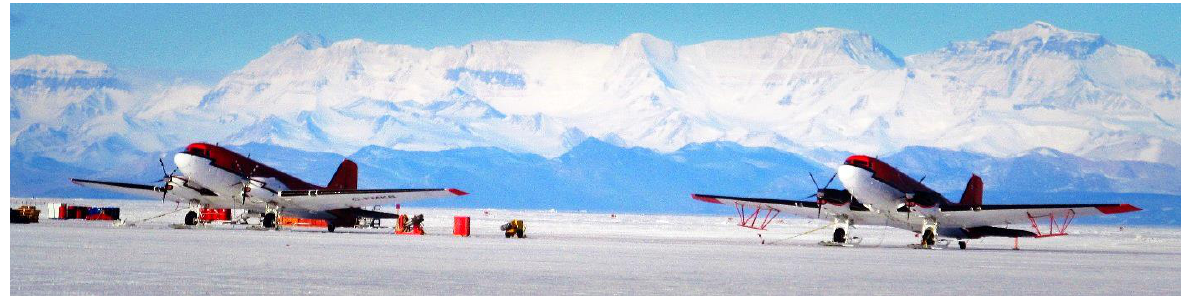
Figure 11. Aircraft on a sea ice runway near McMurdo Station, Antarctica